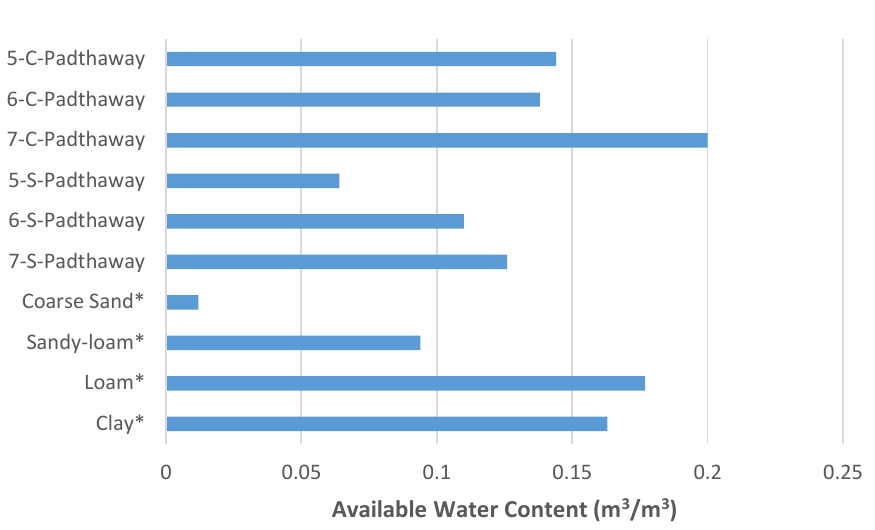
Figure 5. Available water content of biochar samples. Sample Identification: C = Grapevine canes, S = Stalks, 5 = 500 ◦ C Biochar, 6 = 600 ◦ C Biochar, 7 = 700 ◦ C Biochar. * Parameters for coarse sand, sandy-loam, loam, and clay taken from Grant et al.